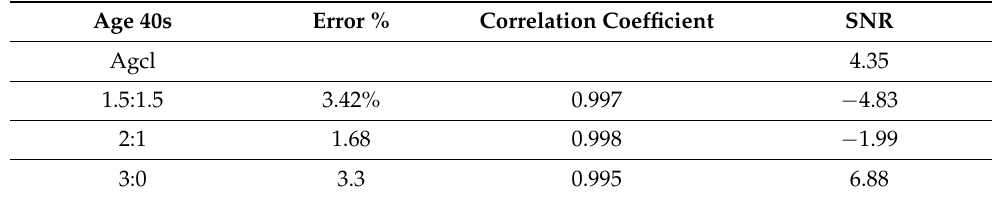
Table 3. Comparison of three different electrode concentrations based on the age group of the 40s.